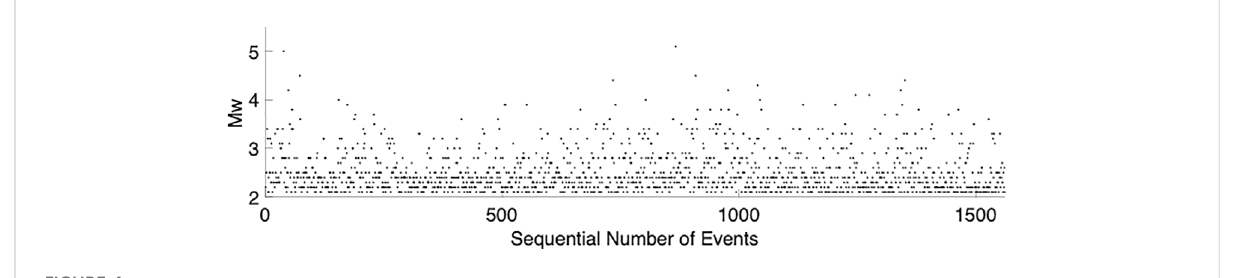
FIGURE 4 Moment magnitudes arranged by the sequential number of events. Mw is set to the obtained magnitude of completeness, Mc=2.1, demonstrating that there is no clear short-term magnitude incompleteness in the data used for the following analysis, within the network coverage area